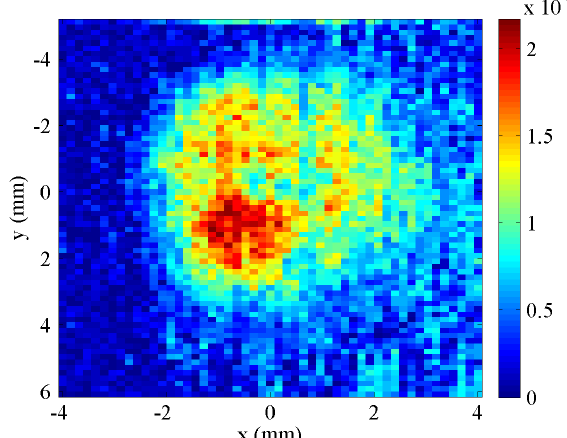
FIG. 31. Typical QE map of the cathode. The length scale at the cathode was determined from the mirror actuator calibration and its distance from the cathode.